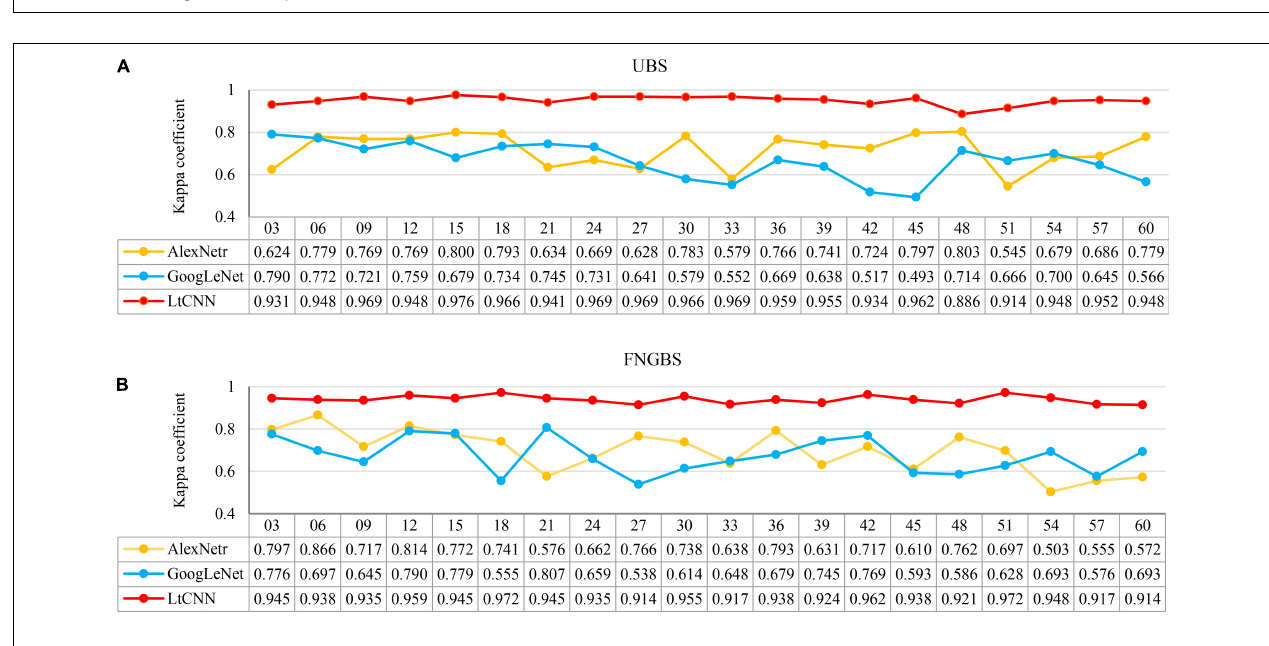
FIGURE 12 | The relationship between the number of bands (M) and produced accuracy when using a subset of hypercube images for classification. Line charts (A,B) present the kappa variation for the uniform band selection (UBS) and Fast Neighborhood Grouping Band Selection (FNGBS) method. The numbers below the M list the kappa values of the CNN